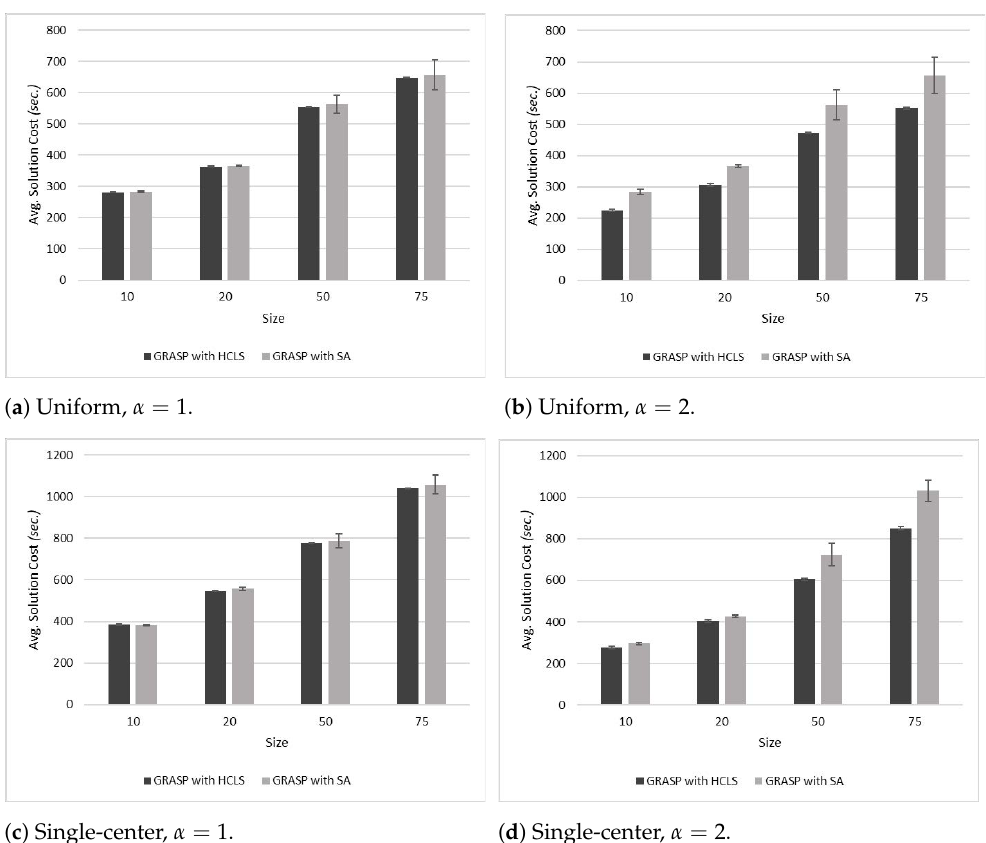
Figure 10. Comparison of the average solution cost obtained with the two GRASP variants–GRASP with HCLS vs. GRASP with SA: ( a ) Uniform distribution, α = 1. ( b ) Uniform distribution, α = 2. ( c ) Single-centered distribution, α = 1. ( d ) Single-centered distribution, α =